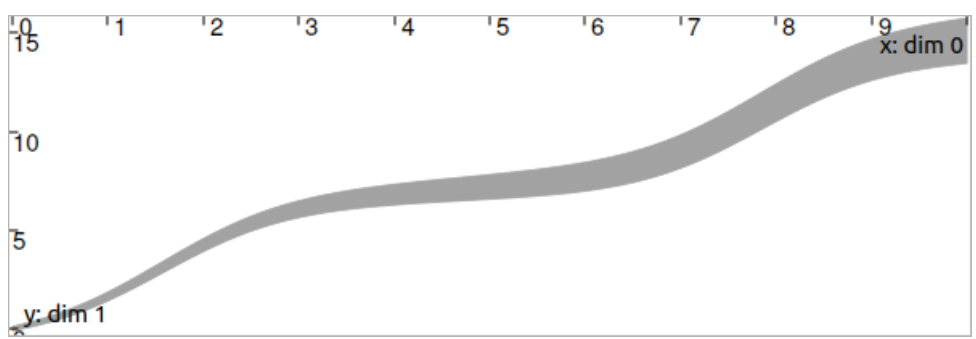
Figure 5. Tube [ x ]( · ) obtained after contraction with Codac.